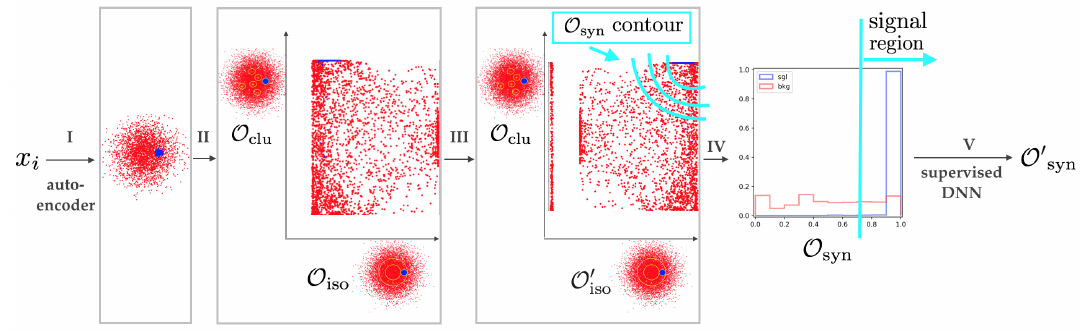
Figure 2 . Workflow for the proposed novelty-detection scheme at